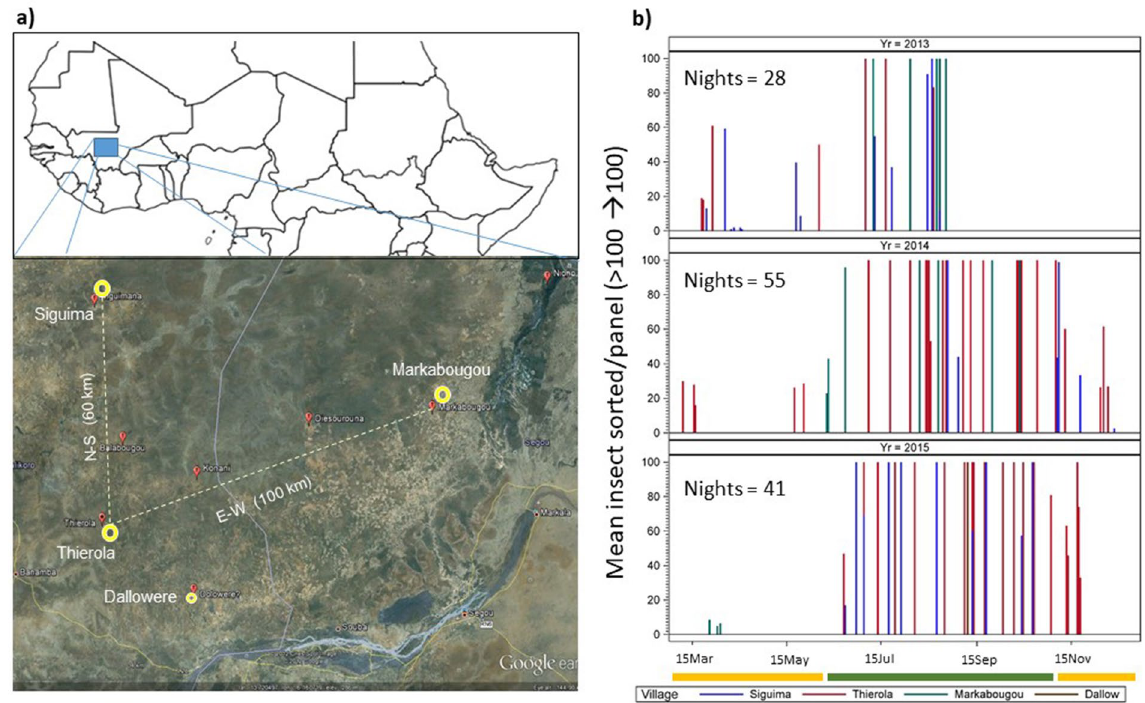
Figure 1. ( a ) Map of study area (Map data: Google, Maxar Technologies) under a schematic map of Africa above the equator. The base map was generated using the ggplot2 package in R 74 , under a GPL-2 license. Aerial collection sites are shown in yellow with distance between them (the small symbol of Dallowere indicates that only two sampling nights in Dallowere were included in the present study). ( b ) Sampling effort of high-altitude flying insects by year. Needles represent sampling nights (by village: color) extending up to 100 insects per panel (actual number of insects can exceed 2000). Dry and wet seasons are indicated by yellow and green bands, respectively, under the x axis. Note: no sampling was done during